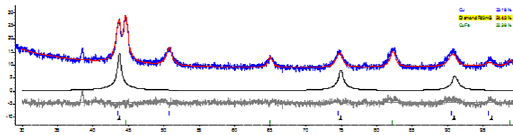
Figure 6. Rietveld refinement of the products obtained from the TNT explosive detonation.